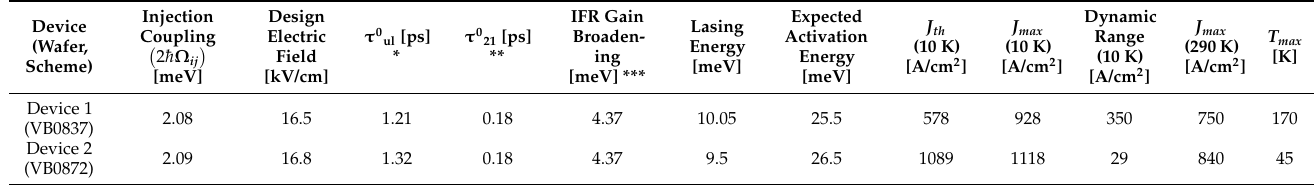
Table 2. Device parameters and performance.